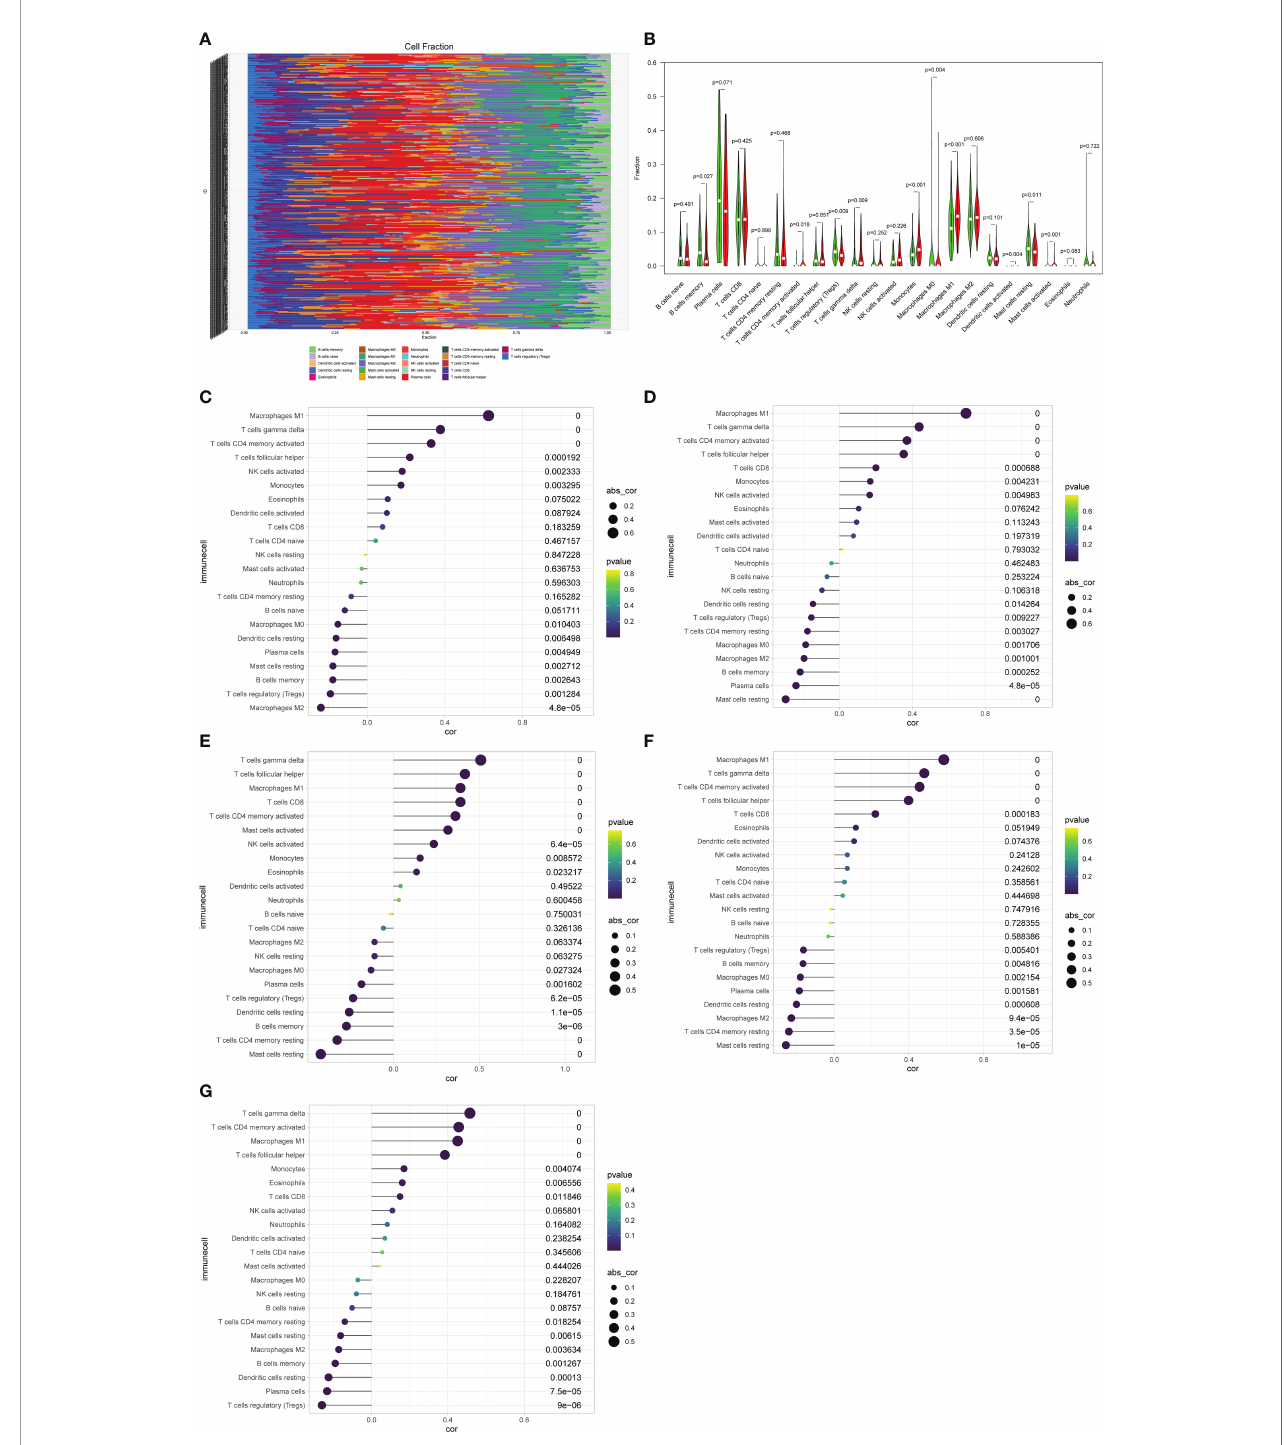
FIGURE 6 | Immune cell proportions in the discovery cohort. (A) A bar plot of the immune cell proportions in no-rejection and rejection samples. (B) A violin plot of the immune cell proportions in the discovery cohort. Blue and red colors represent no-rejection and rejection samples, respectively. (C – G) Correlation between prognostic-related genes and immune